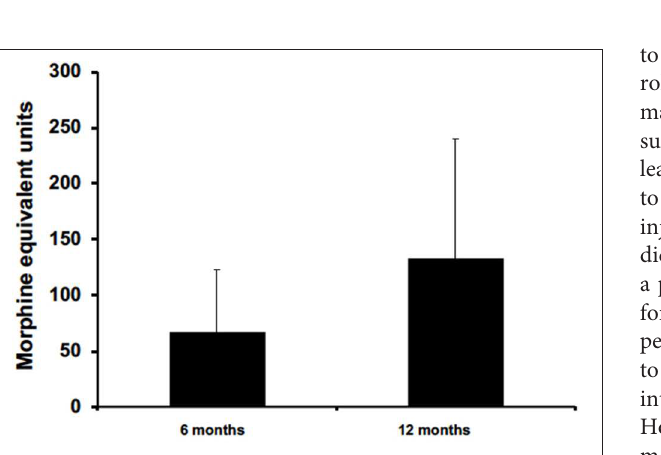
FIGURE 4 | BoNTA treatment reduced headache days in single non-migraine headache types in a time dependent manner. n = 2–11, † p < 0.05 vs. 0 month.